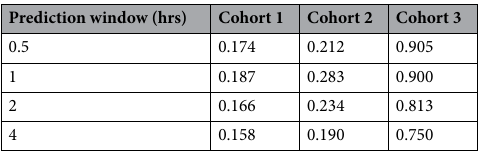
Prediction window (hrs) (a) Cohort 1 - Cardiac Surgery Cohort (Training Set)